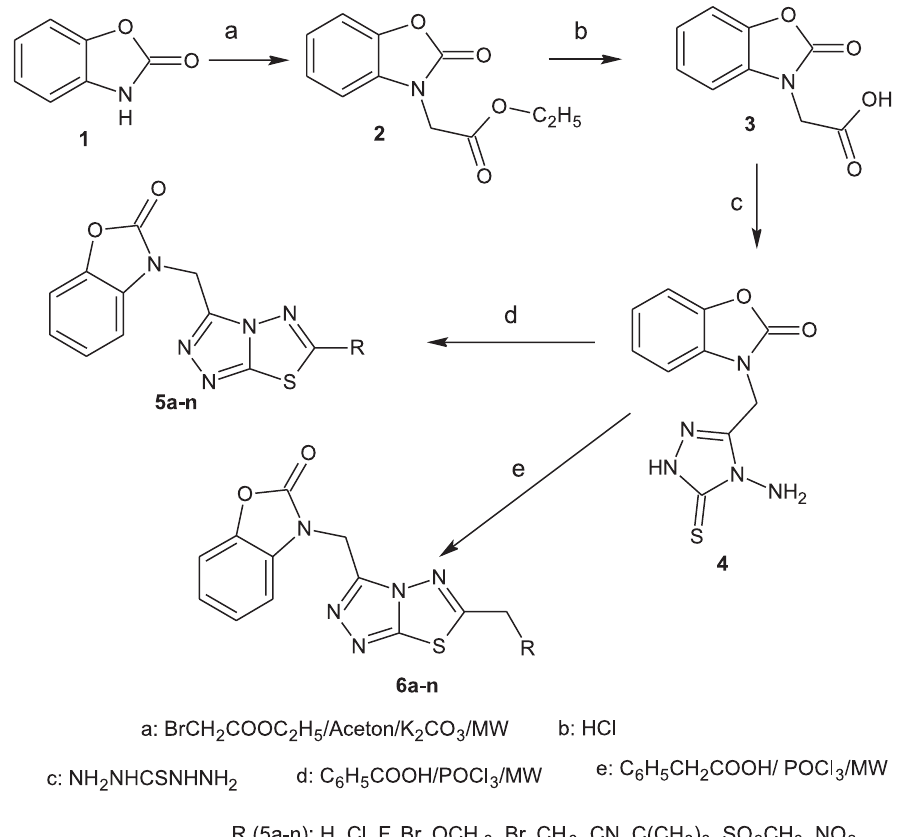
FIGURE 1 - Synthesis of compounds 5a-n and